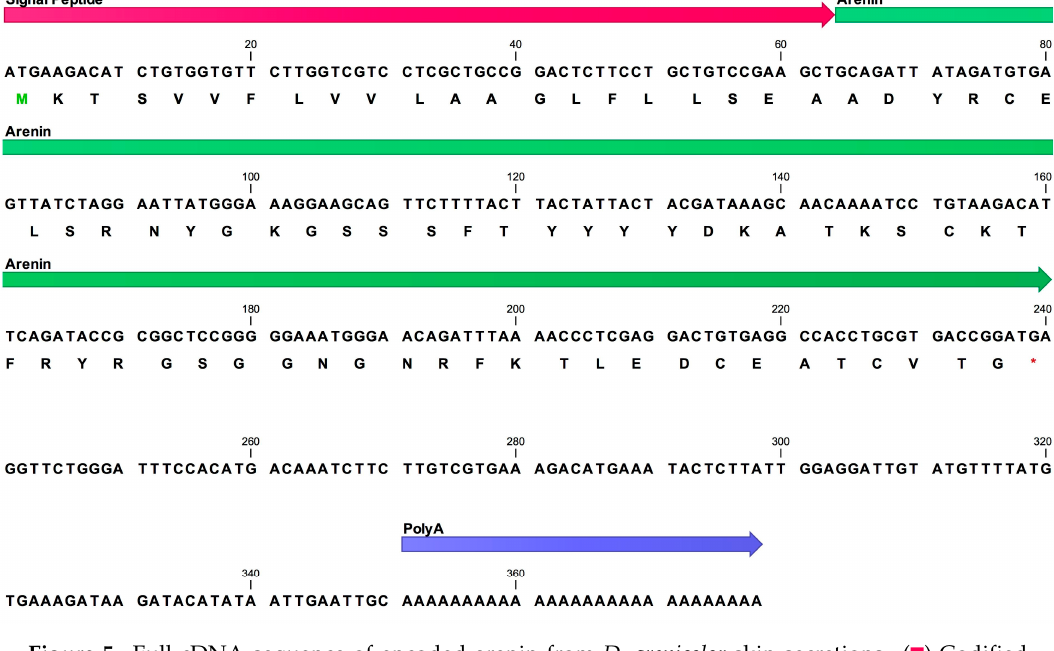
Figure 5. Full cDNA sequence of encoded arenin from D. arenicolor skin secretions. ( ) Codified and translated signal peptide, ( ) nucleotide and amino acid sequences of the mature polypeptide arenin, ( ) Poly A signal. Green residue indicates translation initiation codon. Red asterisks indicates translation stop codon.